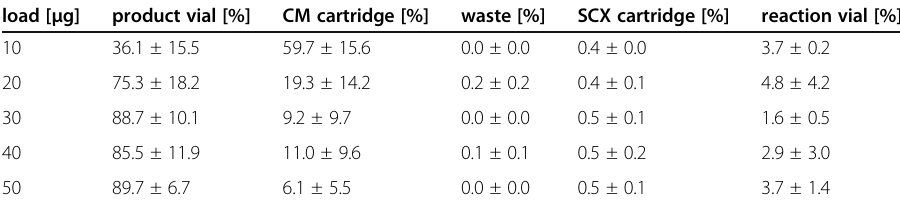
Table 2 Activity measured on different parts of the cassette immediately after synthesis on ML eazy at 98 °C ( n = 3) load [ μ g]